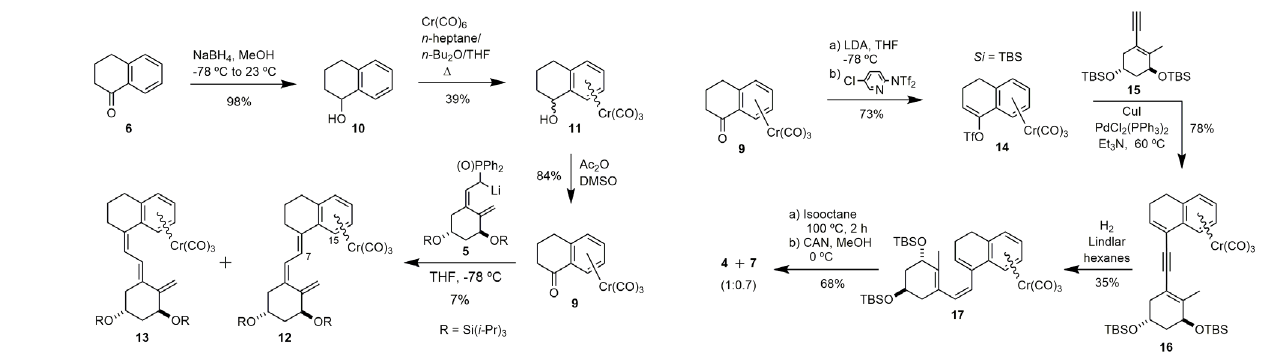
Figure 4 - Effect of Cr(CO) [1,7]-H shift.